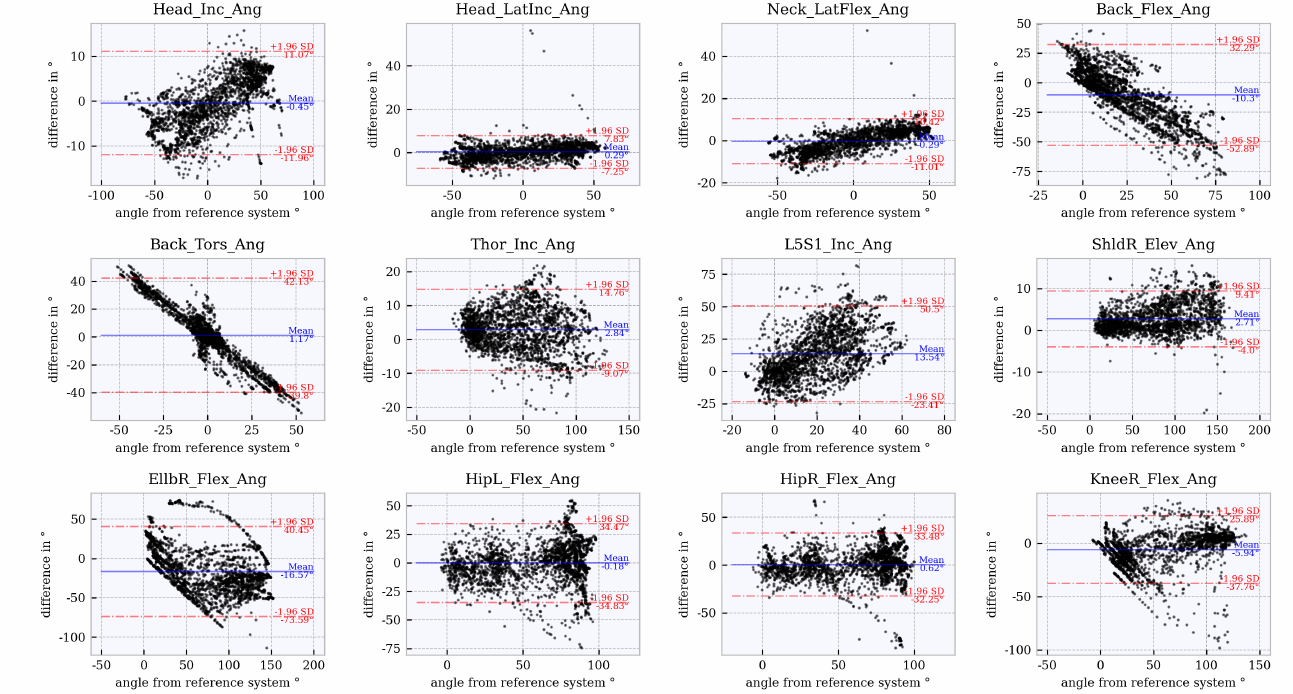
Figure A7. Bland–Altman plot for tracker configuration 9 from WIDAAN ; x does not show the average of both systems but the joint angles of the reference system,